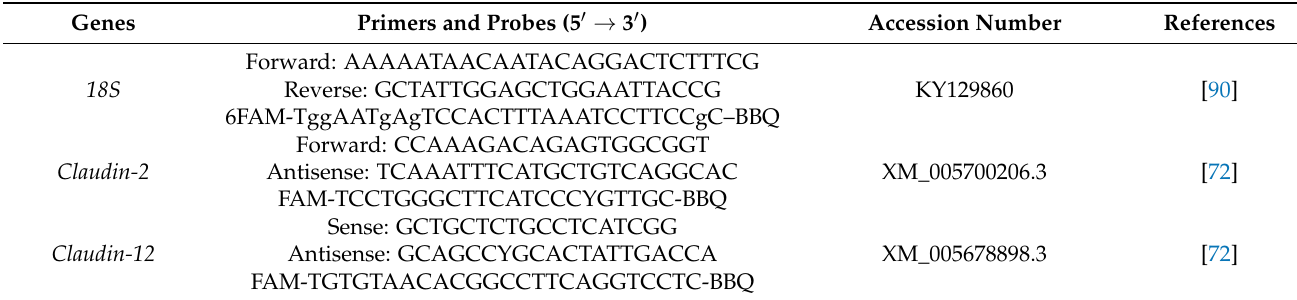
Table 10. Primers and probes used for TaqMan™ assays.